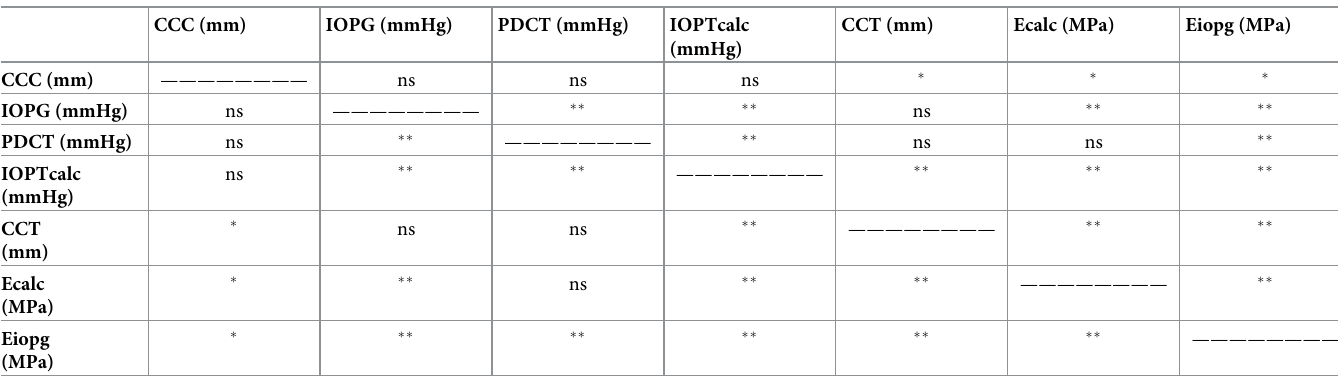
Table 2. Significance of Pearson correlations for the variables ( � = p < 0.05, �� = p < 0.001). CCC